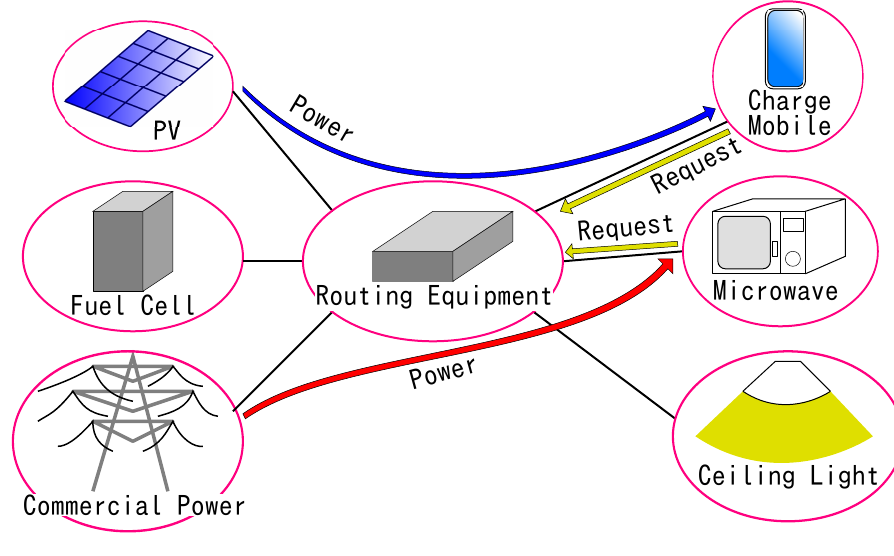
Figure 1. AC power distribution system in